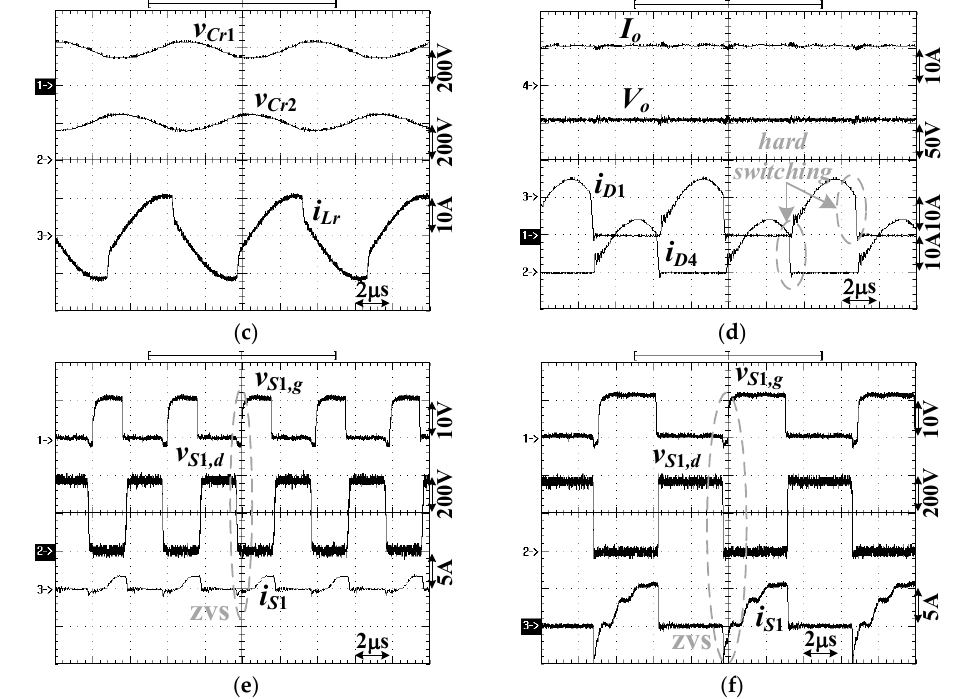
Figure 10. Experiments of the presented converter under V o = 95 V: ( a ) v S 1 ,g , v S 2 ,g , v S 3 ,g , and v S 4 ,g under V in = 760 V and P o = 1 kW; ( b ) v S 1 ,g , v ab , and v bc under V in = 760 V and P o = 1 kW; ( c ) v Cr 1 , v Cr 2 , and i Lr under V in = 760 V and P o = 1 kW; ( d ) I o , V o , i D 1 , and i D 4 under V in = 760 V and P o = 1 kW; ( e ) v S 1 ,g , v S 1 ,d , and i S 1 under V in = 760 V and P o = 200 W; and ( f ) v S 1 ,g , v S 1 ,d , and i S 1 under V in = 760 V and P o = 1 kW.